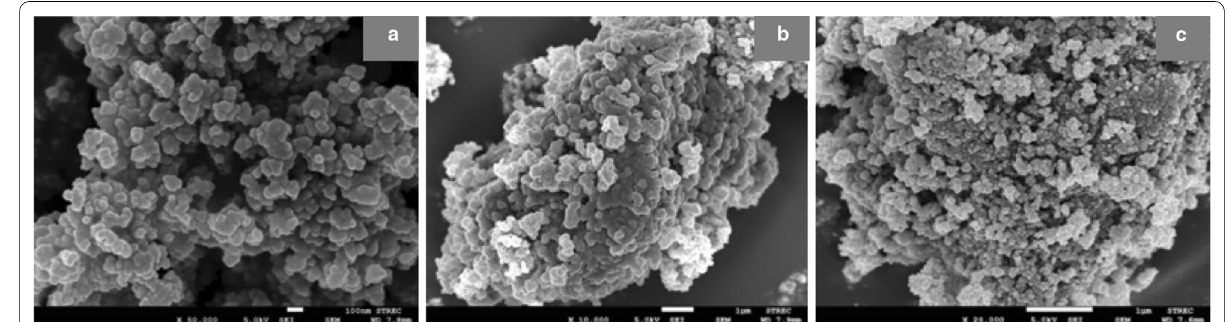
Fig. 3 SEM micrographs of a TiO 2 , b TiO 2 –RGO and c TiO 2